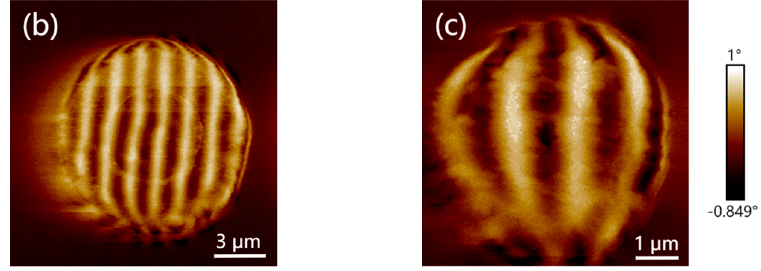
Figure 5. Stripe magnetic domain structure of CoFeB with circular pa tt erns of di ff erent diameters: ( a ) 20 µm, ( b ) 10 µm, ( c ) 5 µm.